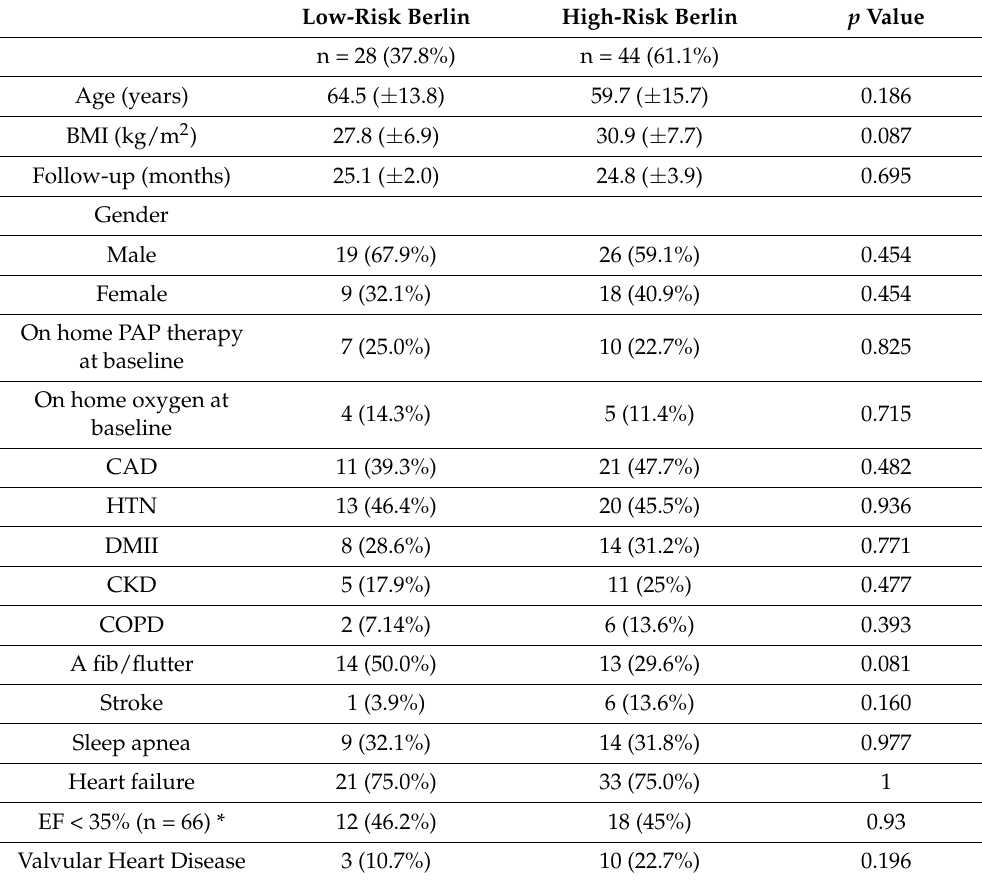
Table 3. Baseline characteristics of AICD subgroup. Low-Risk Berlin High-Risk